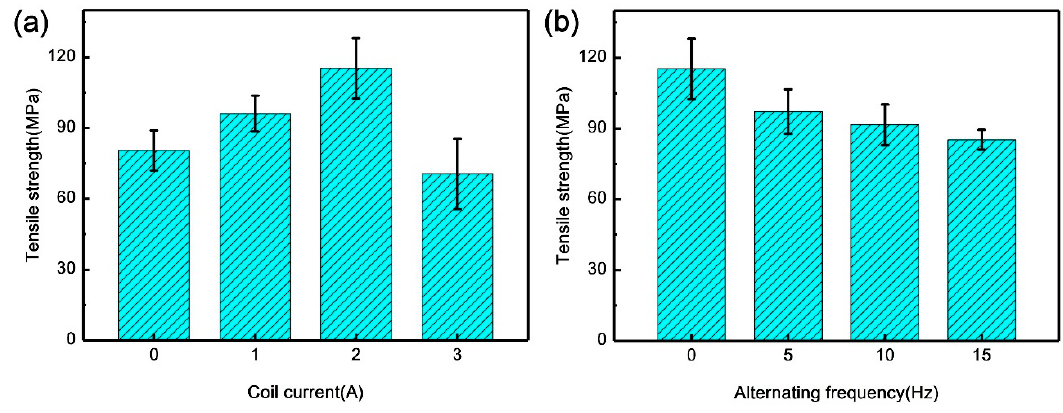
Figure 8. Tensile strength of the specimens with different various field parameters: ( a ) Coil current; ( b ) alternating frequency.